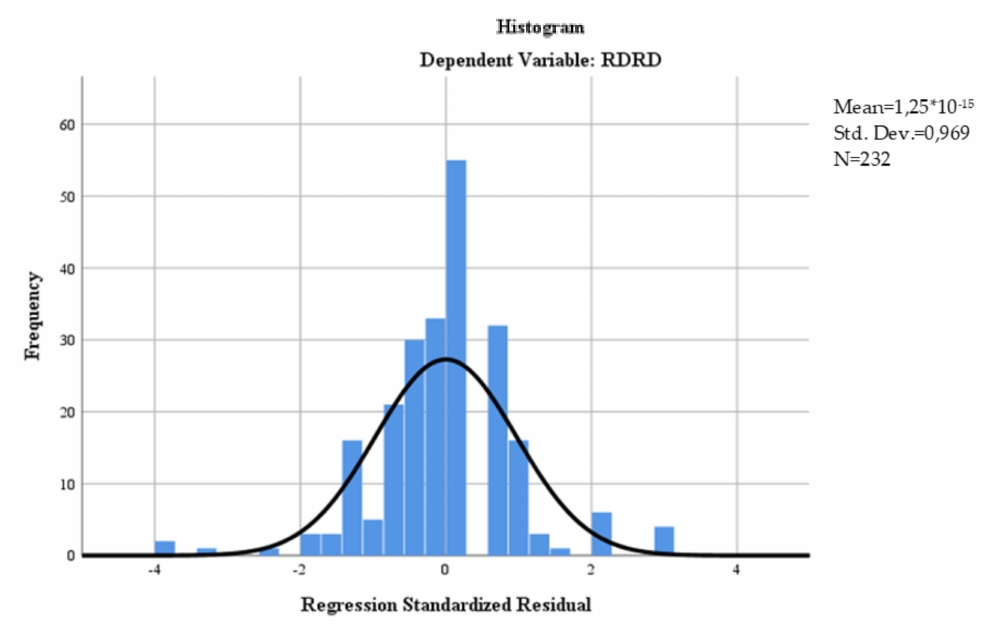
Figure 1. Histogram distribution for RDRD. According to the P-P Plot distribution for the trend line forecast in relation to the observational values, it results that the biggest variations are found in the cases of 3- trade and 1-production, sectors that experience the biggest dynamics at the level of Romanian agriculture. These sectors attract the highest turnover, which explains the distribution of the P-P Plot (Figure 2).